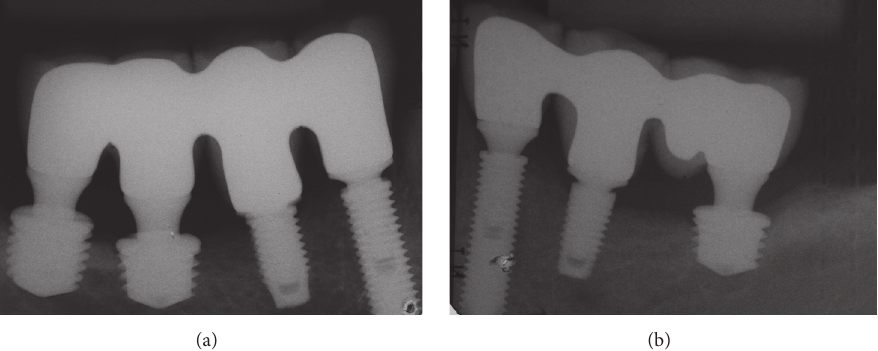
Figure 9: Periapical radiographs at the prosthesis installation session in the mandibular arch: (a) right and (b) left side.